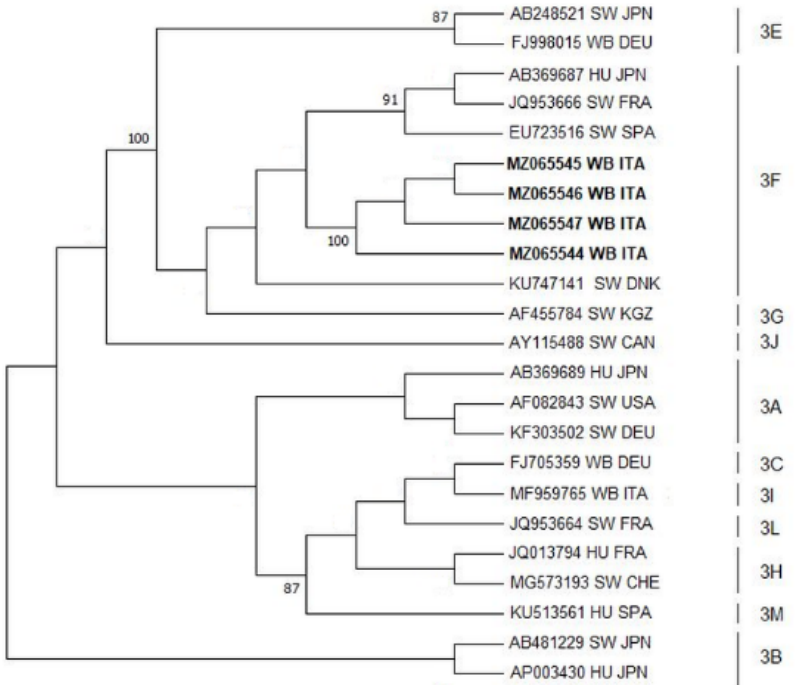
Figure 2. Molecular Phylogenetic analysis by Maximum Likelihood Method: Molecular phylogenetic analysis by Maximum Likelihood method for HEV-3. The evolutionary history was inferred using the Maximum Likelihood method based on the Tamura–Nei model. The percentage of replicate trees in which the associated taxa clustered together in the bootstrap test (100 replicates) is shown next to the branches; bootstrap values lower than 70 have been removed. The analysis involved 23 nucleotide HEV-3 sequences with a total of 347 positions for HEV capsid protein gene in the final dataset. Evolutionary analyses were conducted in MEGA6 [36]. GenBank accession numbers are shown when the available host, host and state are presented. The sequences identified in the present work are represented in bold